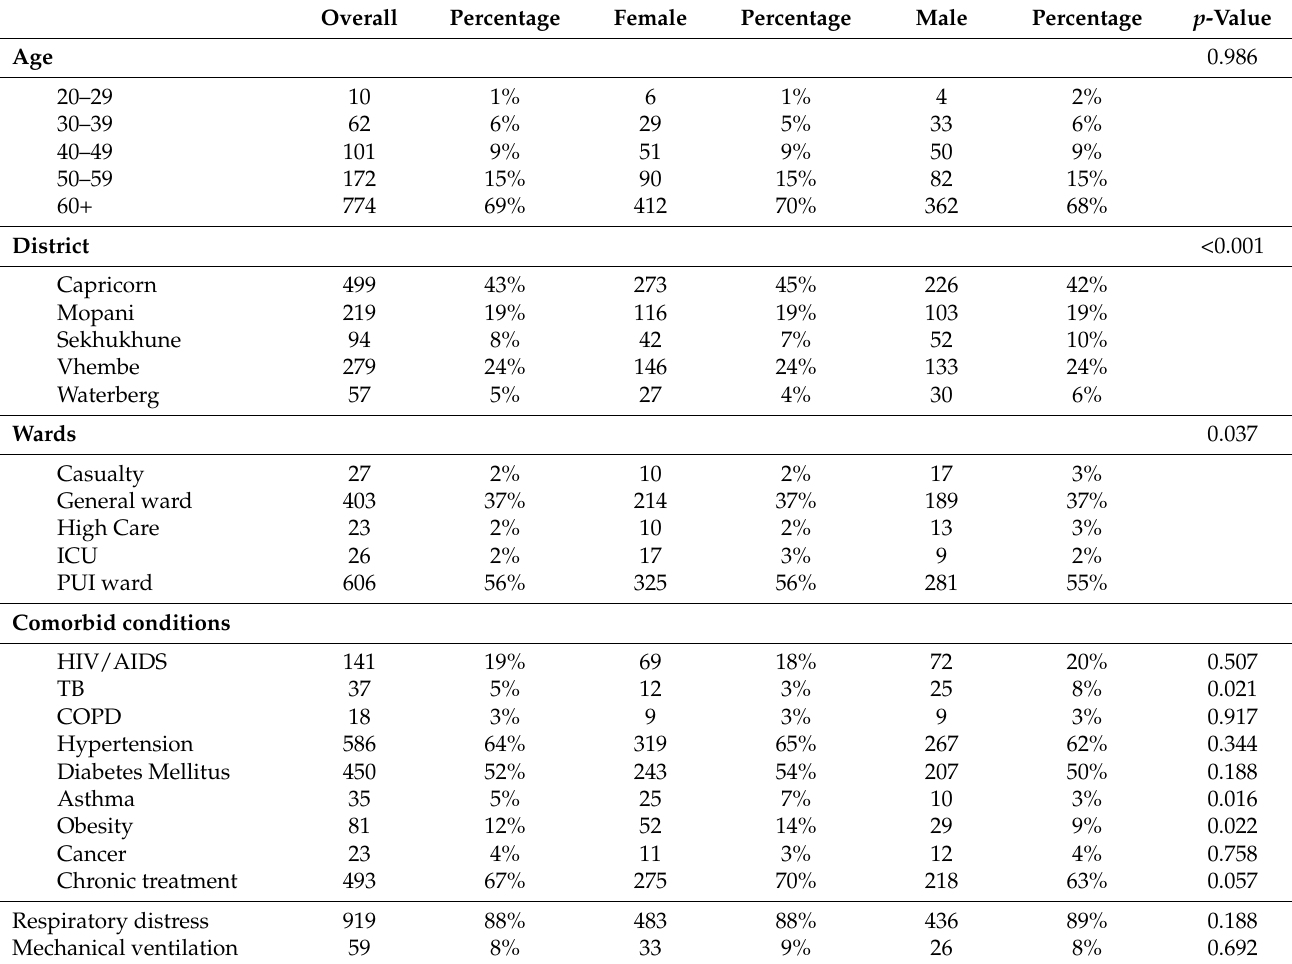
Table 1. Demographic characteristics of patients with clinical syndromes highly suspicious for